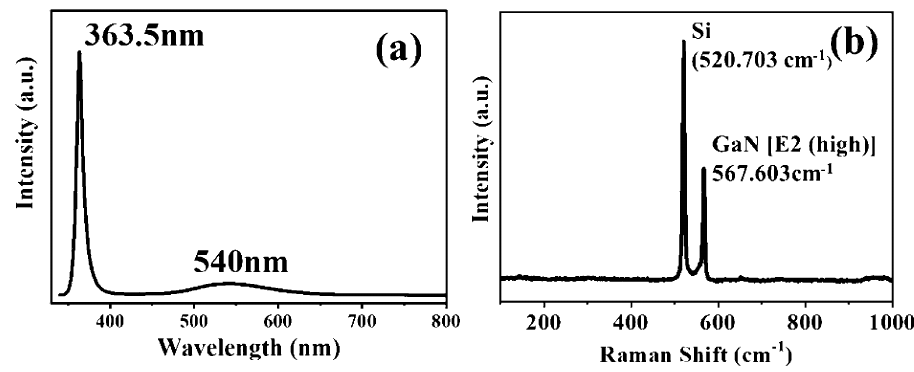
Figure 3. ( a ) RT-PL spectra and ( b ) Raman spectra of as-grown GaN-NTs.